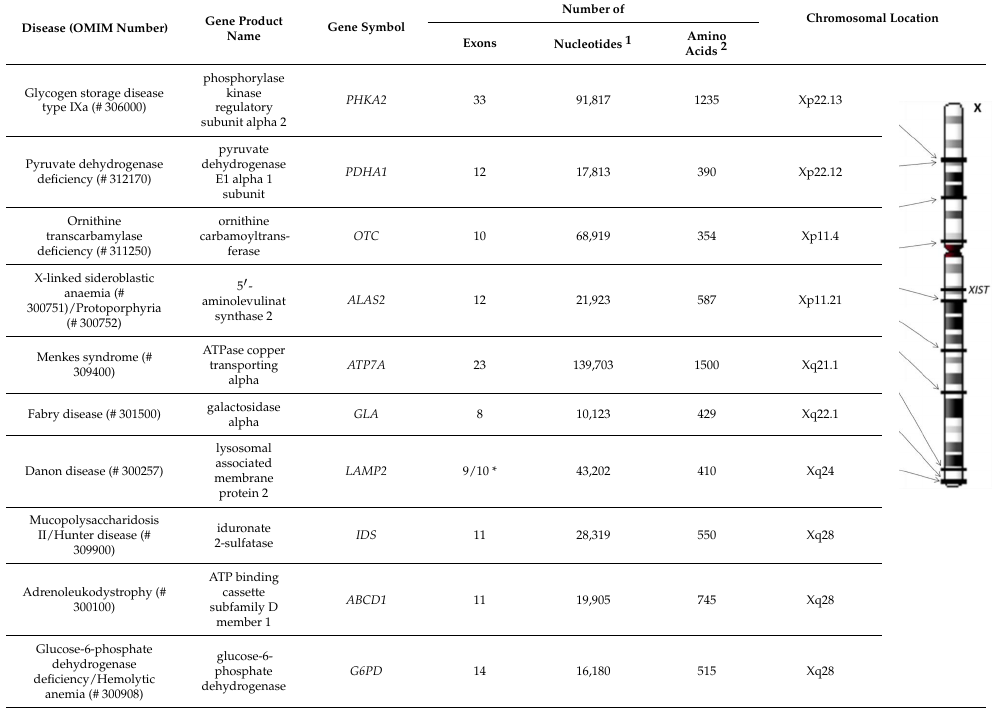
Table 2. Number of mutations in genes associated with the disorders presented in this review described in The Human Gene Mutation Database